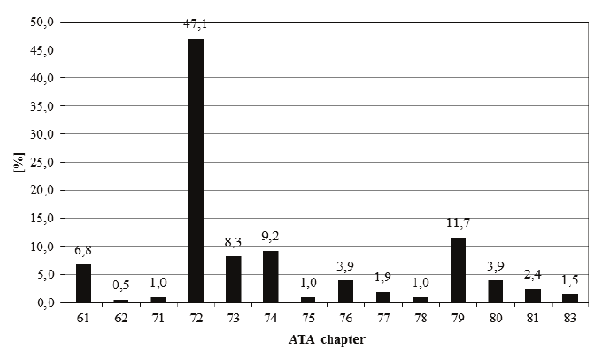
Fig. 7. Share of each powerplant system events coded by ATA 100 chapter between 2008 and 2016